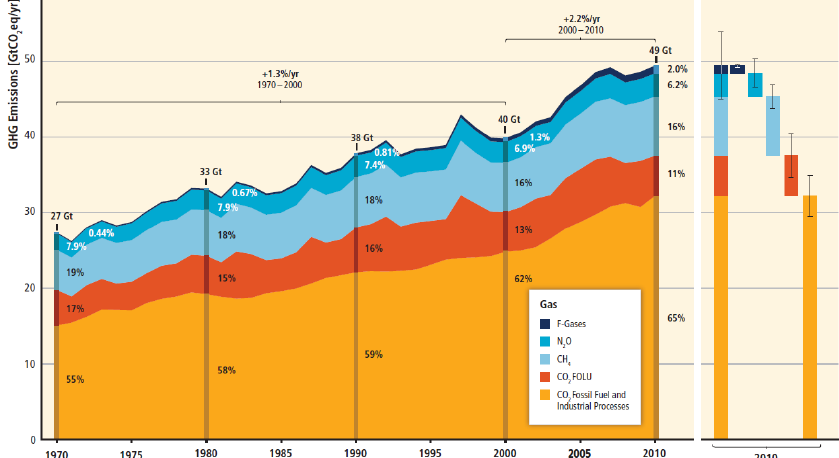
Figure 1. Total annual anthropogenic greenhouse gas (GHG) emissions (GtCO 2eq / yr) by groups of gases from 1970–2010: CO 2 from fossil fuel combustion and industrial processes; CO 2 from forestry and other land use (FOLU); methane (CH 4 ); nitrous oxide (N 2 O); fluorinated gases covered under the Kyoto Protocol (F-gases). On the right side of the figure, the GHG emissions in 2010 are shown, again broken down into the aforementioned components, with the associated uncertainties (90% confidence interval) indicated by the error bars. Global CO 2 emissions from fossil fuel combustion are known to have an uncertainty within 8%. CO 2 emissions from FOLU have very large uncertainties, to the order of ±50%. The uncertainty for the global emissions of CH 4 , N 2 O and F-gases has been estimated at 20%, 60% and 20%, respectively. Emissions are converted into CO 2 -equivalents, based on the 100-year global warming potential (GWP 100 ) from the IPCC Second Assessment Report (AR2). Using the GWP 100 values from the AR5, global GHG emissions totals would be slightly higher (52 GtCO 2eq /yr), and non-CO 2 emissions shares would be 20% for CH 4 , 5.0% for N 2 O and 2.2% for F-gases [4].